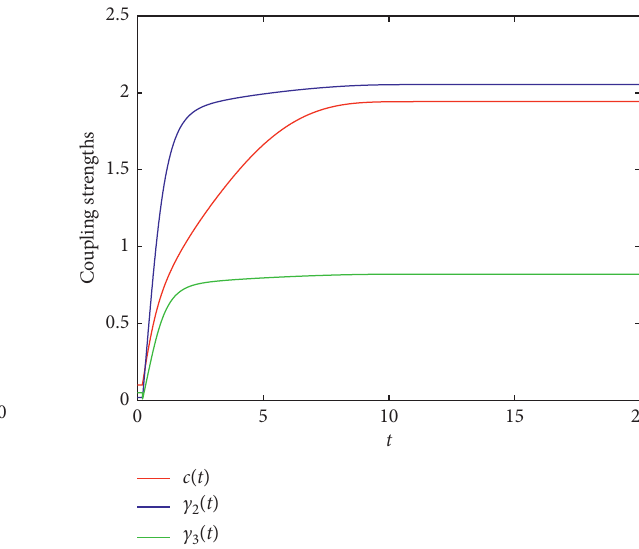
Figure 11: The orbits of c ( t ) and c